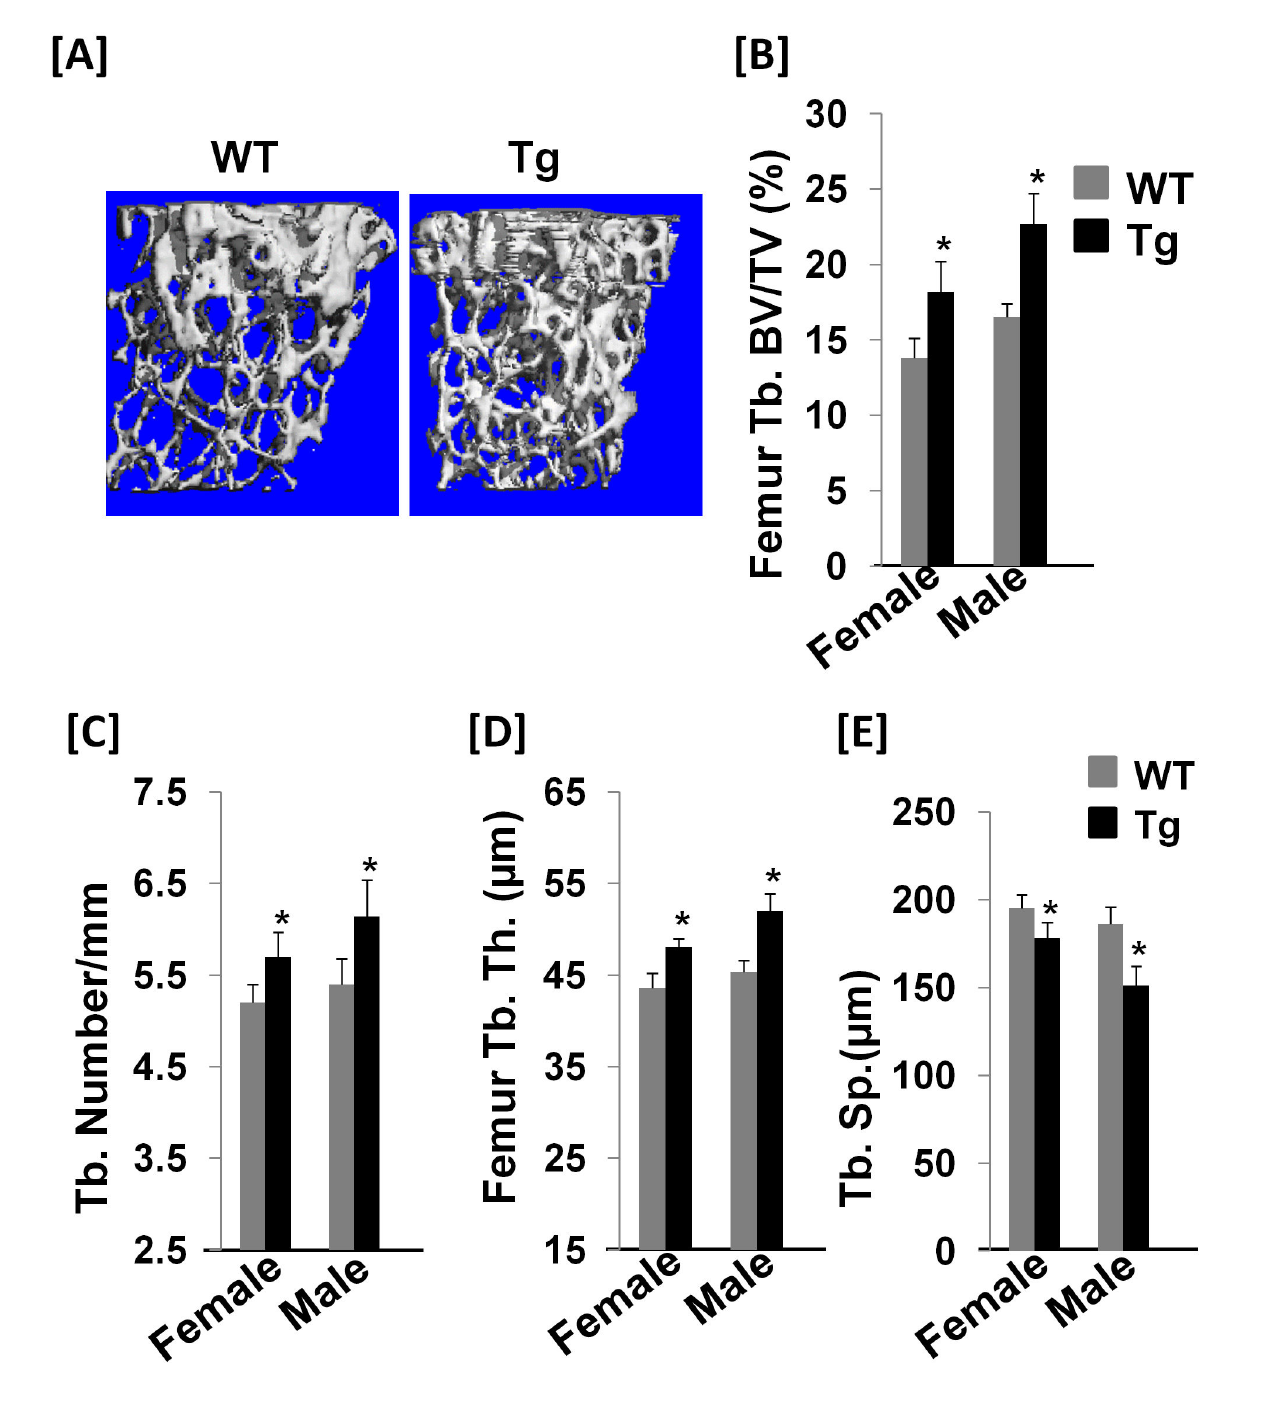
Figure 4. Col3.6-Tg efnb1 mice demonstrate increased trabecular bone and cortical thickness. [A] 3-D micro-CT images of the distal femural metaphysis of 8 week old WT and Tg male mice. [ B-E ] Quantitative data of μ-CT analyses, including trabecular bone volume to total volume (Tb. BV/TV), trabecular thickness (Tb. Th.), trabecular number (Tb. N), and trabecular spacing (Tb. Sp.). Data are means ± SEM for N = 7 per group. A star represents statistical significance (P < 0.05) when compared to WT littermate controls.